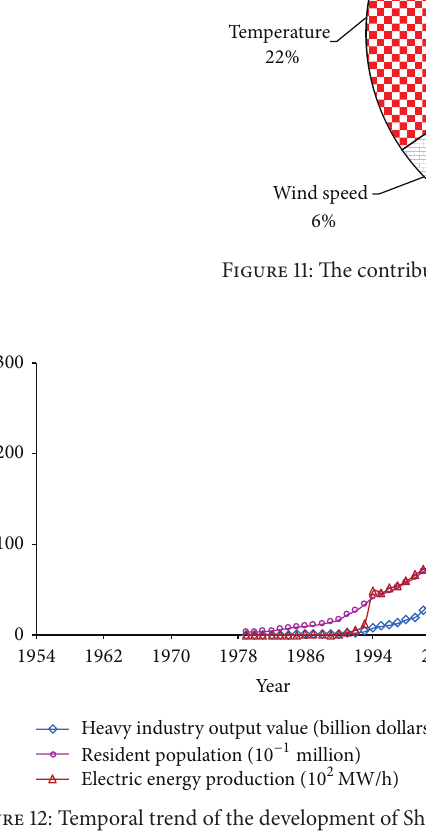
Figure 12: Temporal trend of the development of Shenzhen